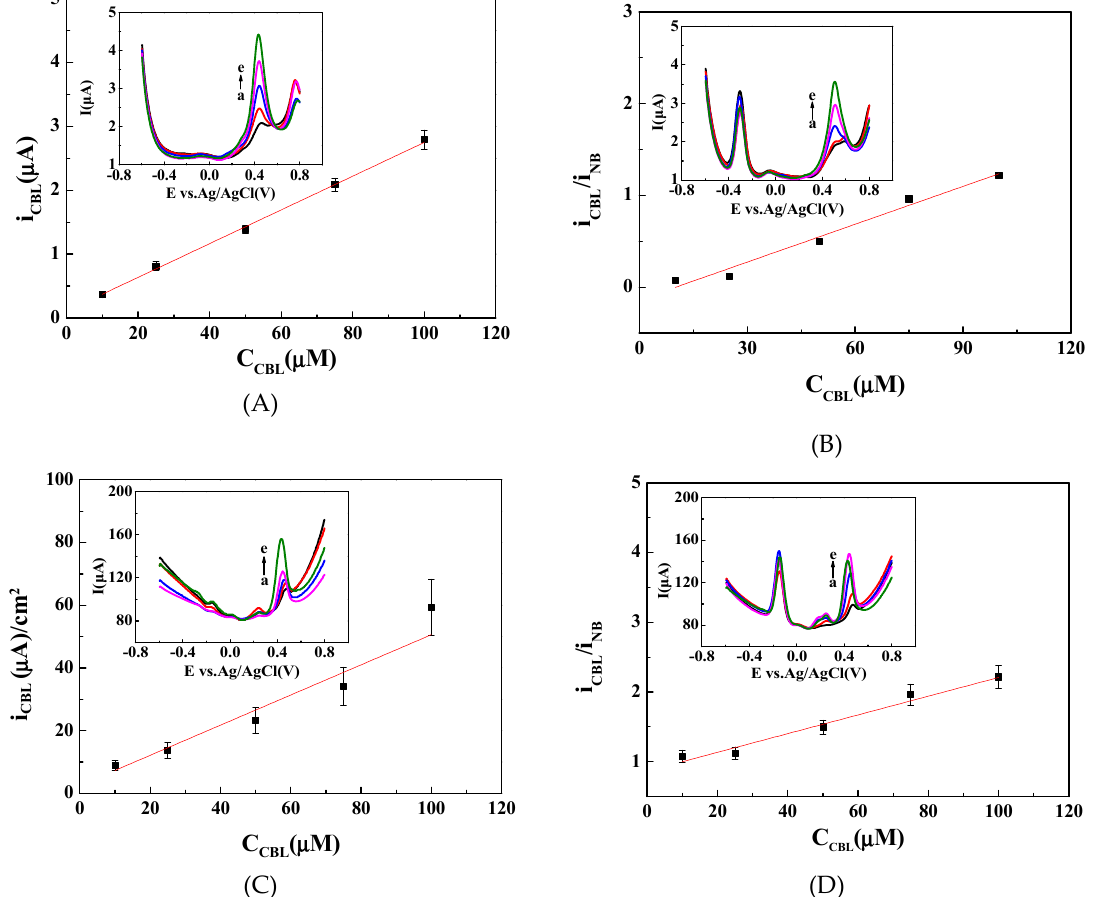
Figure 6. ( A ) Calibration curves of CBL using single-signal strategy on bare GCE in tomato samples. ( B ) Calibration curves of CBL using dual-signal strategy on bare GCE in tomato samples. ( C ) Calibration curves of CBL using single-signal strategy on IL / CC in tomato samples. ( D ) Calibration curves of CBL using dual-signal strategy on IL / CC in tomato samples. Isnet: SWV curves of various concentration of CBL. Error bars: SD; n =